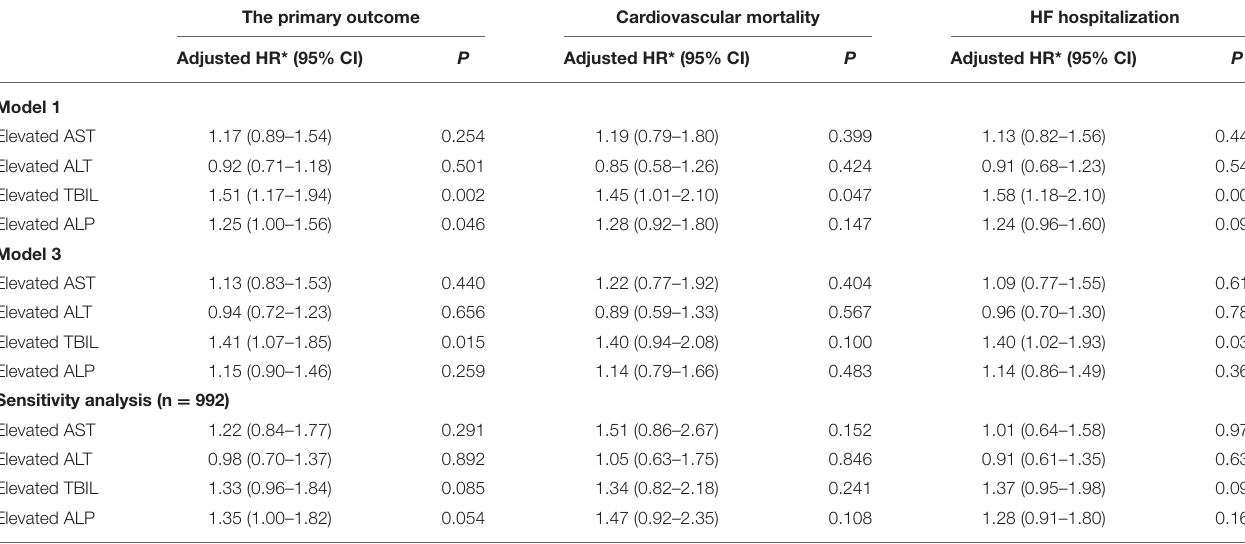
TABLE 3 | Associations of liver function tests as binary variable (Normal vs. Elevated) and clinical outcomes.